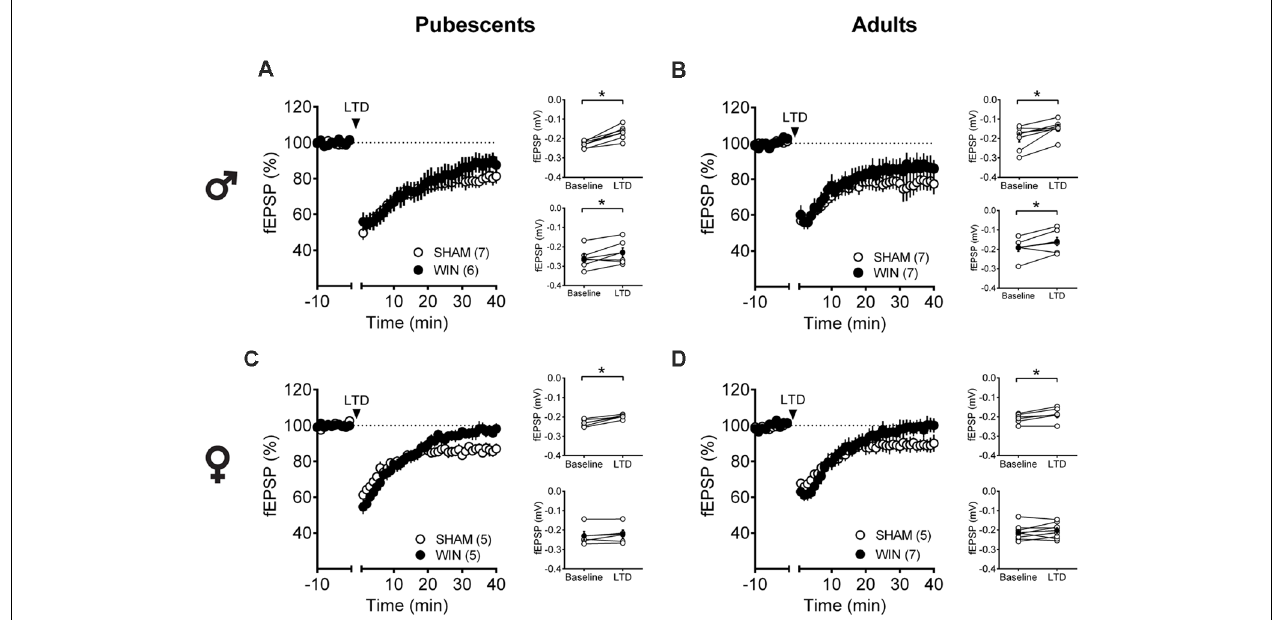
FIGURE 5 | Sex-specific effects of a single in vivo cannabinoid exposure on prefrontal cortex (PFC) endogenous cannabinoid (eCB)-long-term depression (LTD). Rats were exposed to WIN55,212-2 (WIN, 2 mg/kg, s.c.) 24 h before. Average time-courses of mean field excitatory postsynaptic potentials (fEPSPs) showing that low-frequency stimulation (indicated by arrow) induced LTD at mPFC synapses in both Sham- (white circles, n = 7) and WIN- (black circles, n = 6) exposed pubescent males (A) . Similarly, LTD was identical in Sham- (white circles, n = 7) and WIN- (black circles, n = 7) exposed adult males (B) . In contrast, LTD was ablated in mPFC slices obtained from both pubescent ( C , Sham, white circles, n = 5; WIN, black circles, n = 5) and adult ( D , Sham, white circles, n = 5; WIN, black circles, n = 7) females 24 h after a single exposure to WIN. Adjacent to the time-course figures individual experiments (white circles) and group average (Sham, gray circles; WIN, black circles) before (baseline) and after (35–40 min) LTD induction are showed. LTD is present in WIN-treated male rats at both ages: pubescent ( A , on the right) and adulthood ( B , on the right). In contrast, LTD was absent in both pubescent ( C , on the right) and adult ( D , on the right) females previously treated with WIN. Error bars indicate SEM, n = individual rats, ∗ p < 0.05, Paired t -test. Males; ♂ ♀